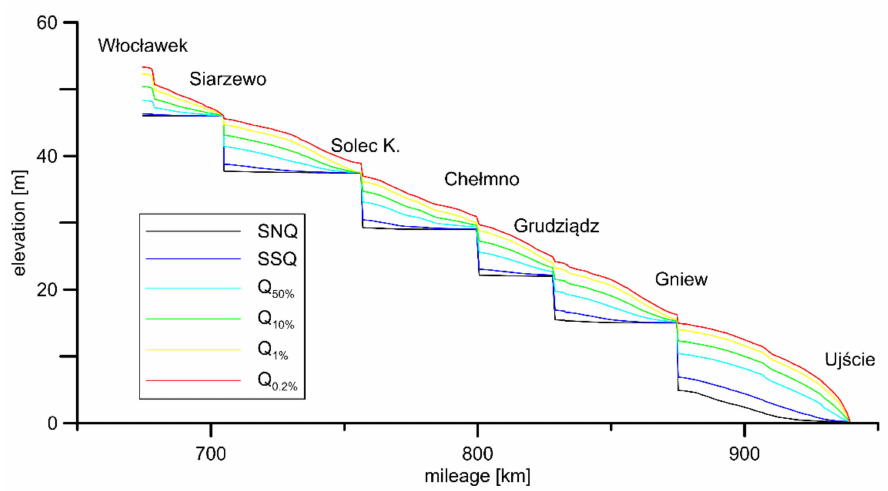
Figure 5. Position of the water levels in 2078 for the characteristic flow conditions after construction of the cascade according to SII